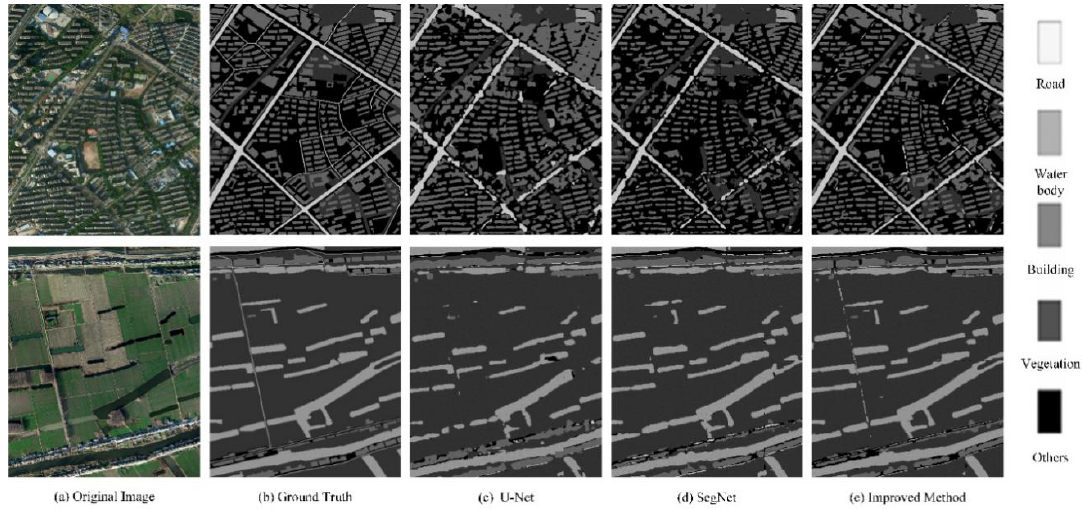
Figure 10. Experimental results of different remote sensing image classification algorithms.